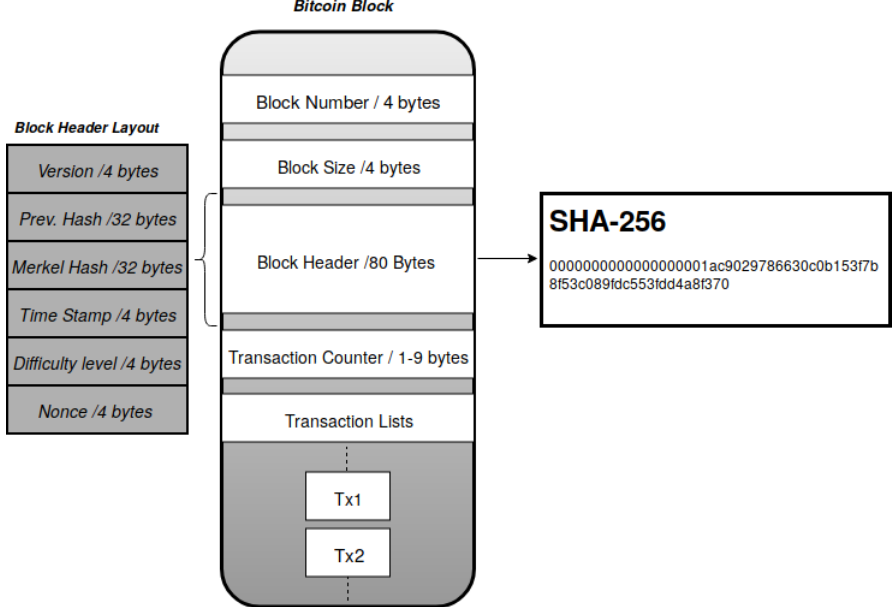
Figure 1. The layout of a bitcoin block. The block number contains a 4-byte arbitrary number confirming it as a bitcoin block, and the block size ensures the size of the block. A block header layout shows its contents. The block header is hashed using SHA-256 and the hash value to be added to the “previous hash” section of the next block header. The transaction counter counts the total number of transactions, and the transaction list contains the list of all transactions added to the